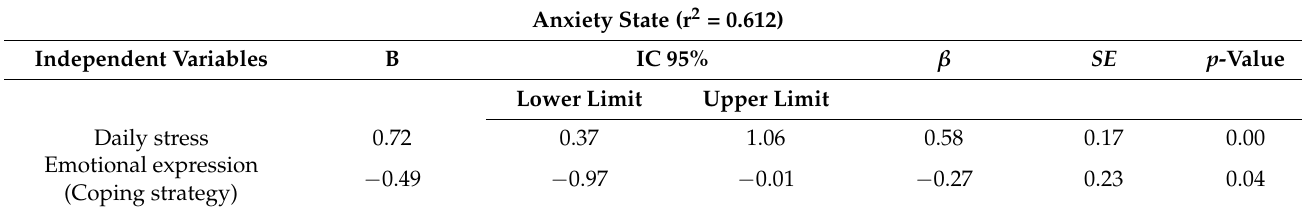
Table 5. Regression of “anxiety” from the variables of suicidal risk, daily stress, prosociality, perceived emotional intelligence, empathy, measures of prosocial tendency, and coping